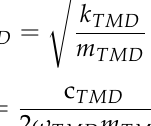
Table 3. Dynamic characteristics of the building frames. Ref.